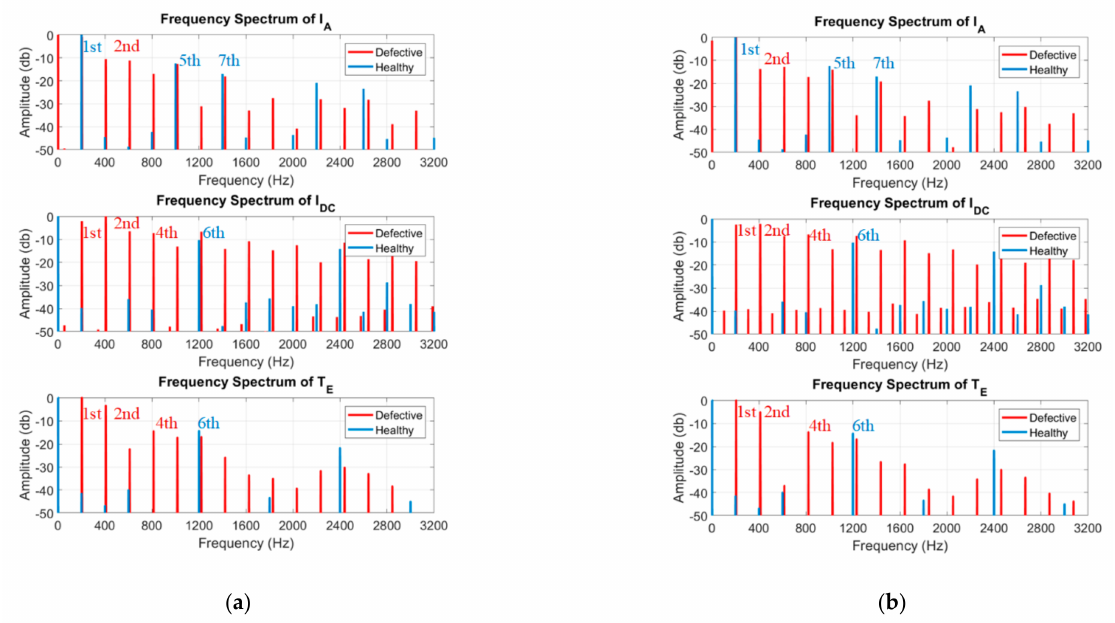
Figure 11. Comparison of phase current, DC-link current, and electromagnetic torque frequency spectra in case of rated speed and load operating point for the healthy and defective configuration of Hall-effect position sensor A breakdown fault. ( a ) Defective sensor A at high state; ( b ) Defective sensor A at low state.